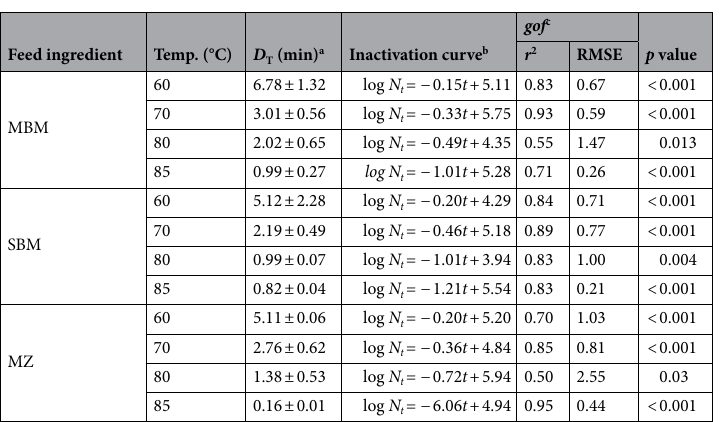
Table 2. D T and inactivation curves of ASFV in feed ingredients at various temperatures. a Mean ± S.D. of three replicates. b ASFV titer (log N t ) at inactivation time t (min). c Goodness-of-fit.